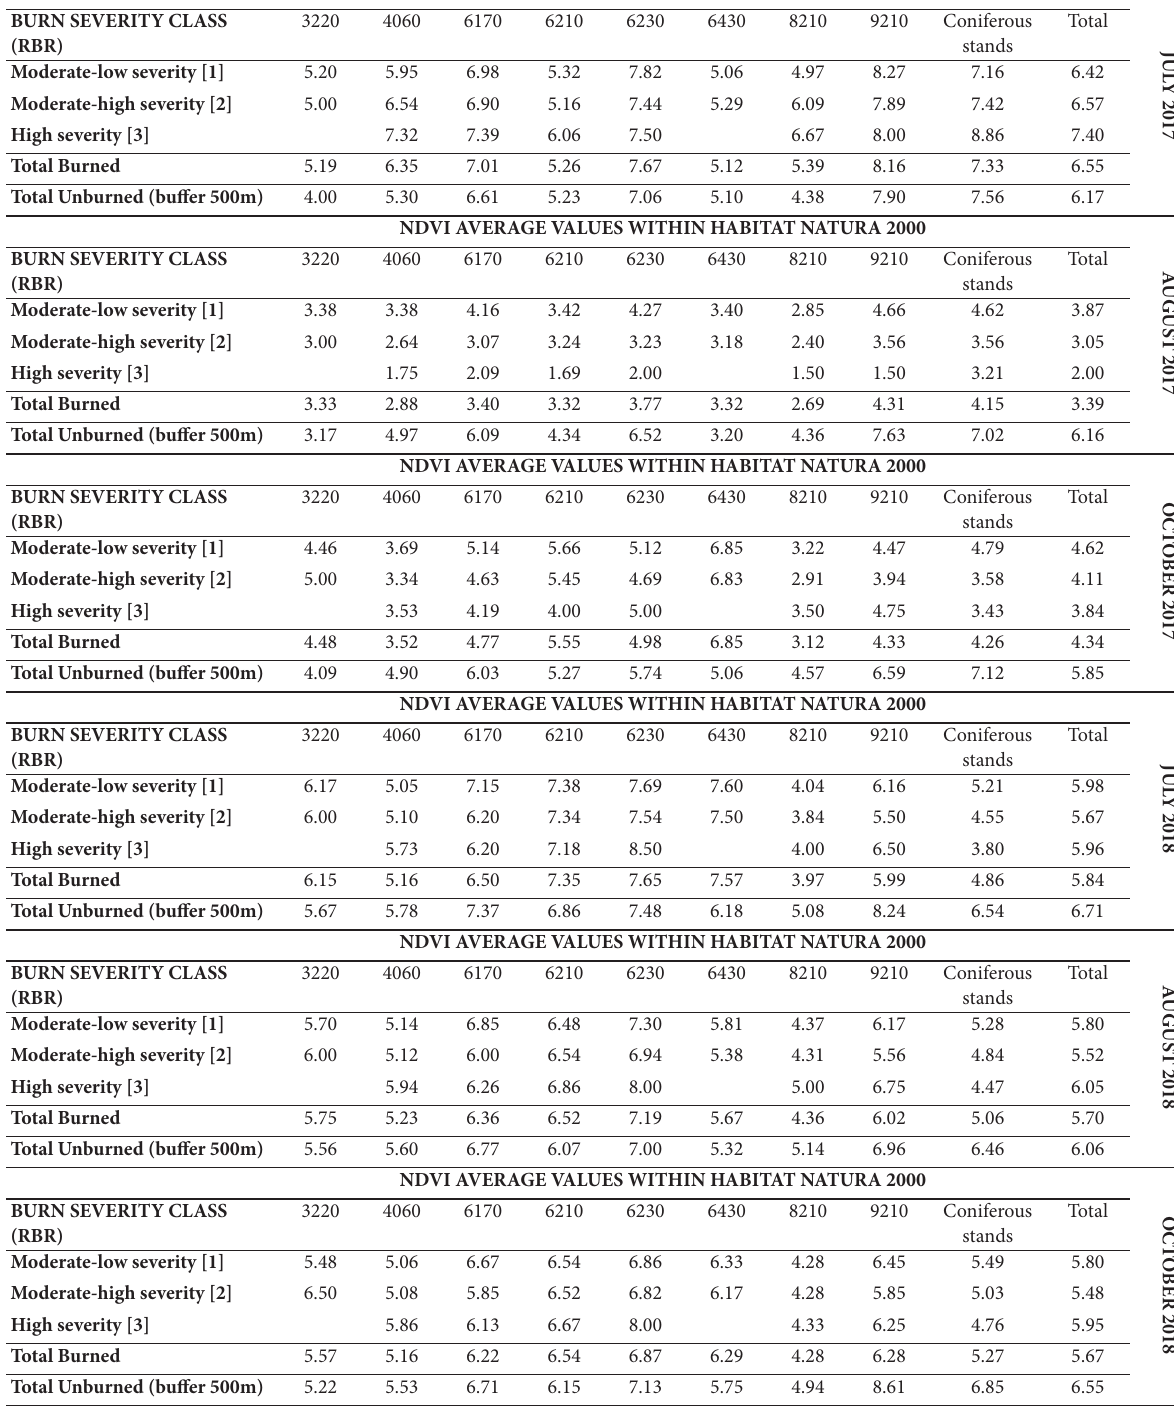
Table 2. Zonal statistics for each Annex I habitat affected by fire within each severity class of the RBR (Relativized Burn Ratio). The NDVI values was discretized into 10 classes with values ranging from 0 (0.0 to 0.1) to 10 (0.9 to 1), with 10 representing the highest photosynthetic activity. The numerical codes of the habitats correspond to: Alpine rivers and the herbaceous vegetation along their banks (3220), Alpine and Boreal heaths (4060), Alpine and subalpine calcareous grasslands (6170), Semi-natural dry grasslands and scrubland facies on calcareous substrates ( Festuco - Brometalia ) (*important orchid sites) (6210*), Species-rich Nardus grasslands, on siliceous substrates in mountain areas and submountain areas, in Continental Europe (6230*), Hydrophilous tall herb fringe commu-nities of plains and of the montane to alpine levels (6430), Calcareous rocky slopes with chasmophytic vegetation (8210), Apennine beech forests with Taxus and Ilex